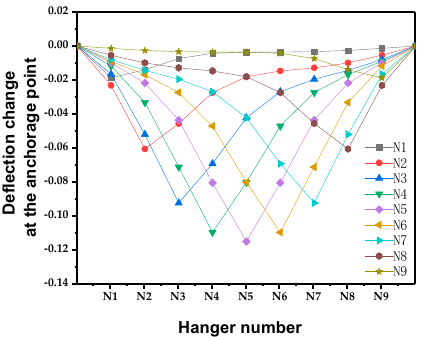
Figure 4. Deflection change of each anchorage point when N1–N9 is wholly damaged.